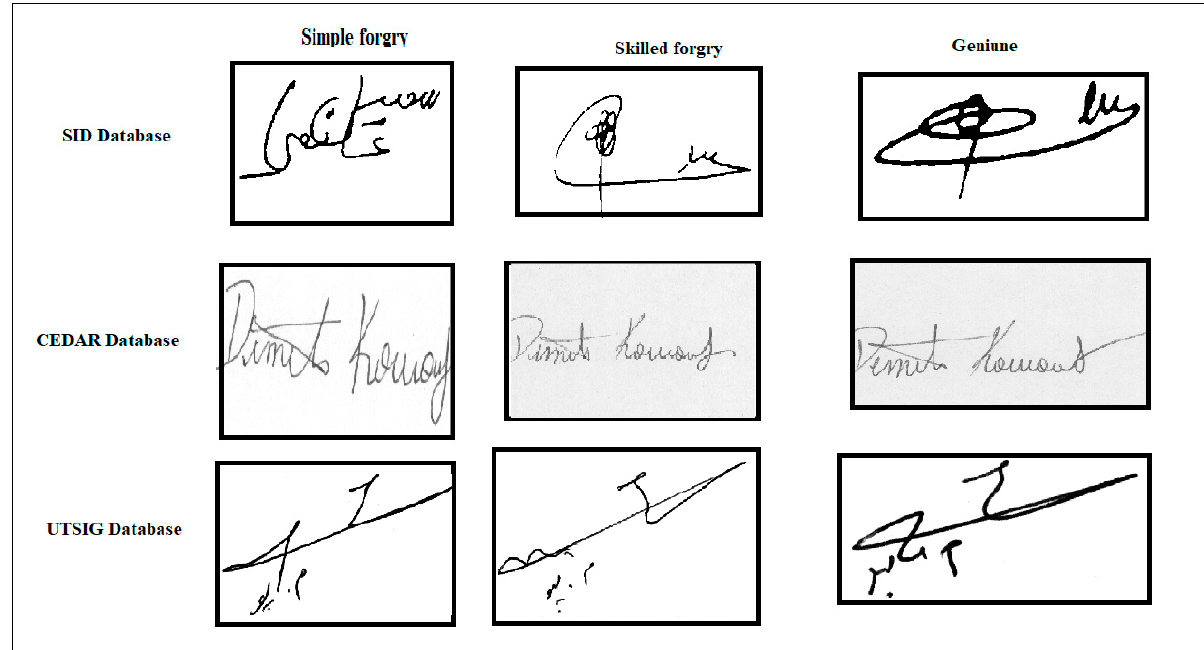
Figure 1. Sample of signatures.